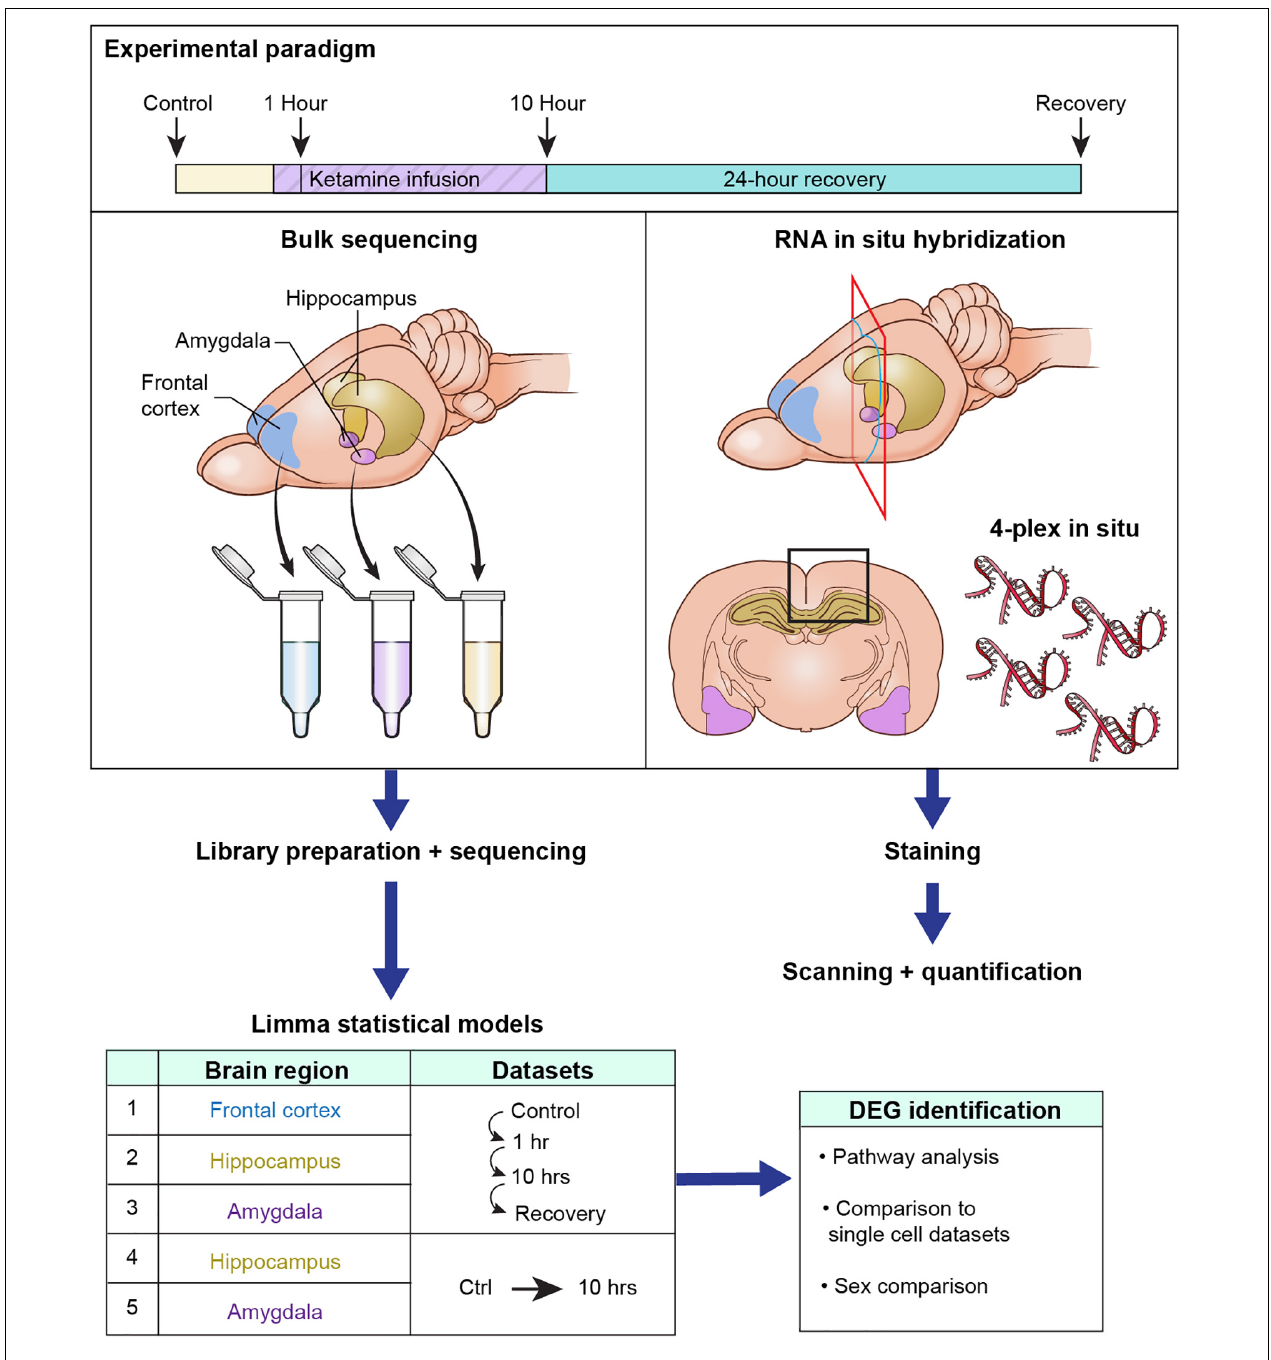
FIGURE 1 | Diagrammatic summary of experimental design and analyses. This study assessed the gene expression changes in brain in response to intravenous ketamine in rats with an implanted femoral vein catheter. Rats were infused with ketamine, and brain tissue was harvested at 1, 10, or 24 h after cessation of a 10 h infusion. Catheterized controls were used as a baseline comparator. The detailed breakdown of N per animal per group is shown in Table 1 . The brain was sub-dissected rapidly into frontal cortex (the entire frontal pole anterior to the forceps minor of the corpus callosum), amygdala, and hippocampus. Bulk RNA-Seq was performed on each homogenized brain region at each time point. Tissue was also collected for multiplex in situ hybridization to examine anatomical distribution of select differential genes quantitatively and qualitatively. After sequencing, 5 statistical models were built inside the limma package (considering each brain region x sex as a separate experiment). The significant genes from each comparison were considered. After identification of differential genes (DEGs), pathway analysis was performed to identify groups of genes changing in concert as part of biological processes. Single cell datasets from other previously published studies were referenced to identify the cellular origin of gene changes within the homogenate. Finally, we examined male and female rats to validate that female rats reproduced some of the most important findings from the experiment.